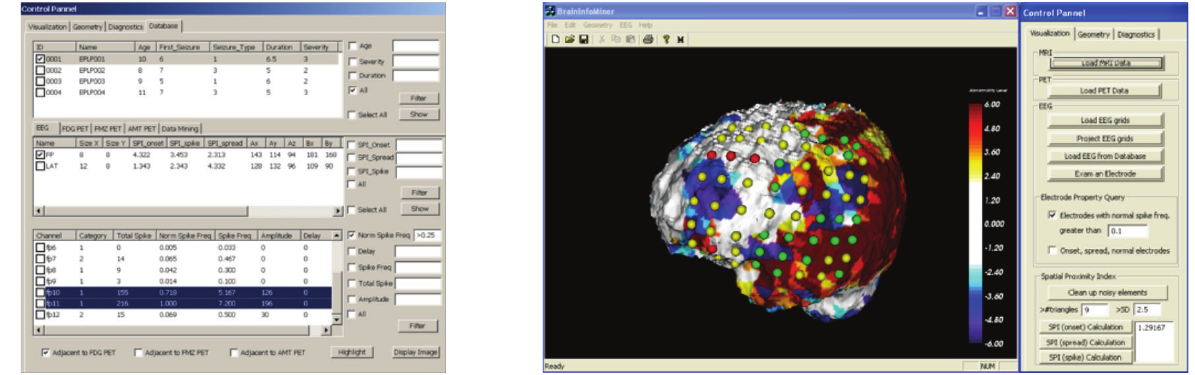
Figure 6: Main control panel which allows access to clinical, electrophysiological, and image data. The imaging module allows coding of EEG parameters (red = seizure onset, yellow = seizure spread, green = normal) and evaluation of each electrode with respect to its location in space by allowing real-time rotation and zoom of all objects in 3D. Furthermore, the SPI parameter which quantifies the spatial relationship between PET and EEG information can be saved in the database for further evaluation across